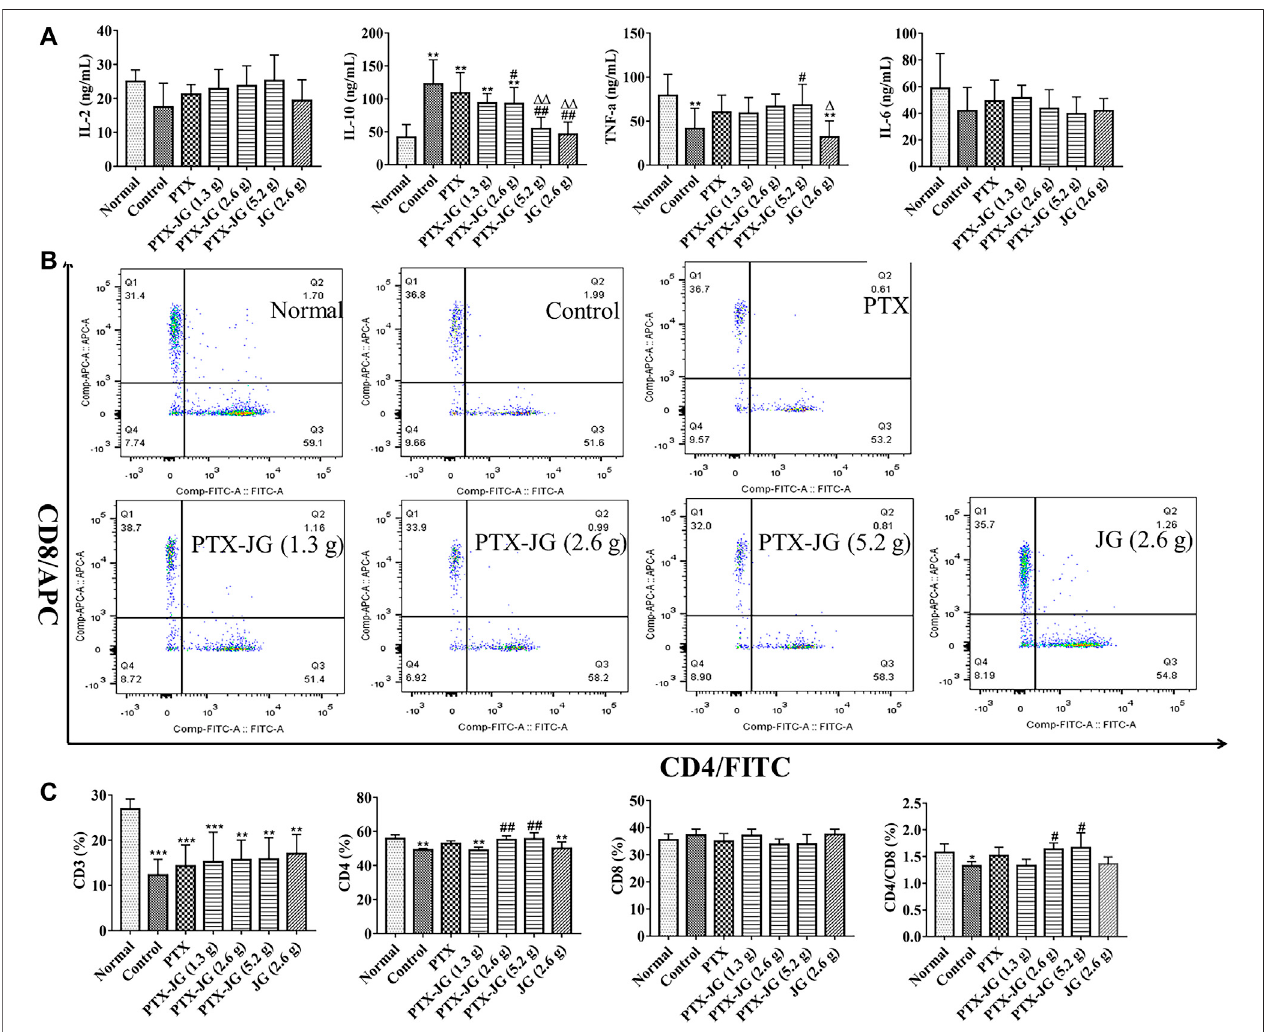
FIGURE 5 | Immune indices of the combination of PTX and JG. (A) : IL-2, IL-10, IL-6 and TNF- α levels were detected by ELISA kit (n = 10). (B) : CD3 + , CD4 + and CD8 + levelsweredetectedby fl owcytometry(n=6). (C) :TheratiosofCD3 + ,CD4 + ,CD8 + TcellsandCD4+/CD8+inspleen(n=6).* p < 0.05,** p < 0.01,*** p < 0.001, vs Normal group; # p < 0.05, ## p < 0.01, vs Control group; △ p < 0.05, △△ p < 0.01, vs PTX